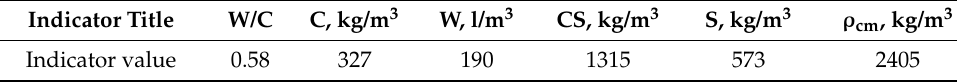
Table 7. Parameters of the composition of the concrete